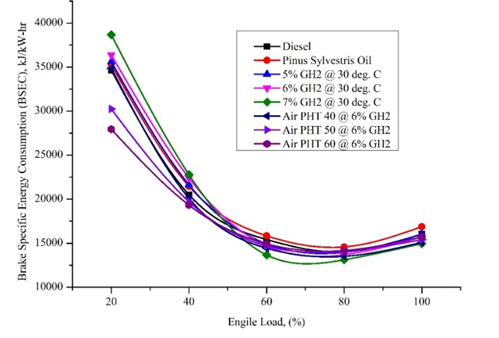
Figure 4 BSEC Vs. Engine Load